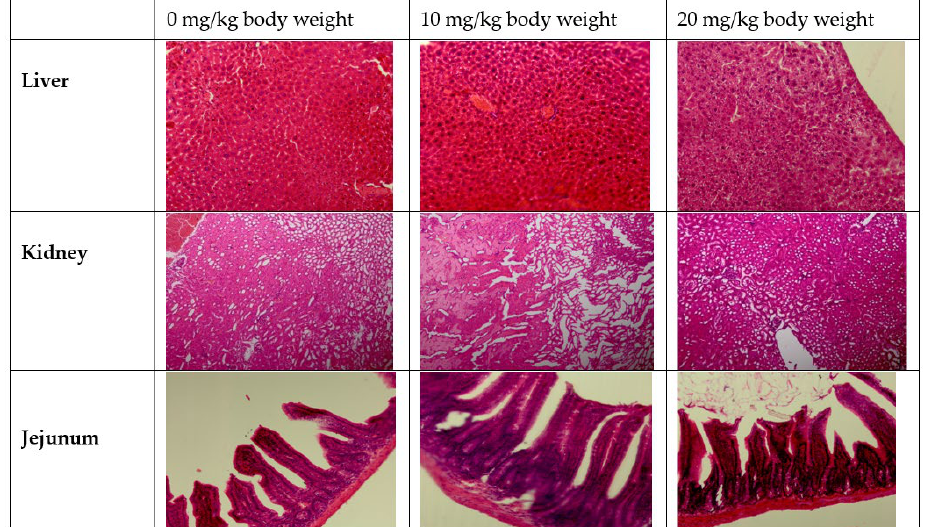
Figure 6. Histopathological analysis of live, kidney and jejunum of the mice treated with differ- ent concentration of Heracleum persicum oil nanoemulsion. Treatment with Heracleum persicum oil nanoemulsion (HAE-NE) showed that cellular death was not detected in